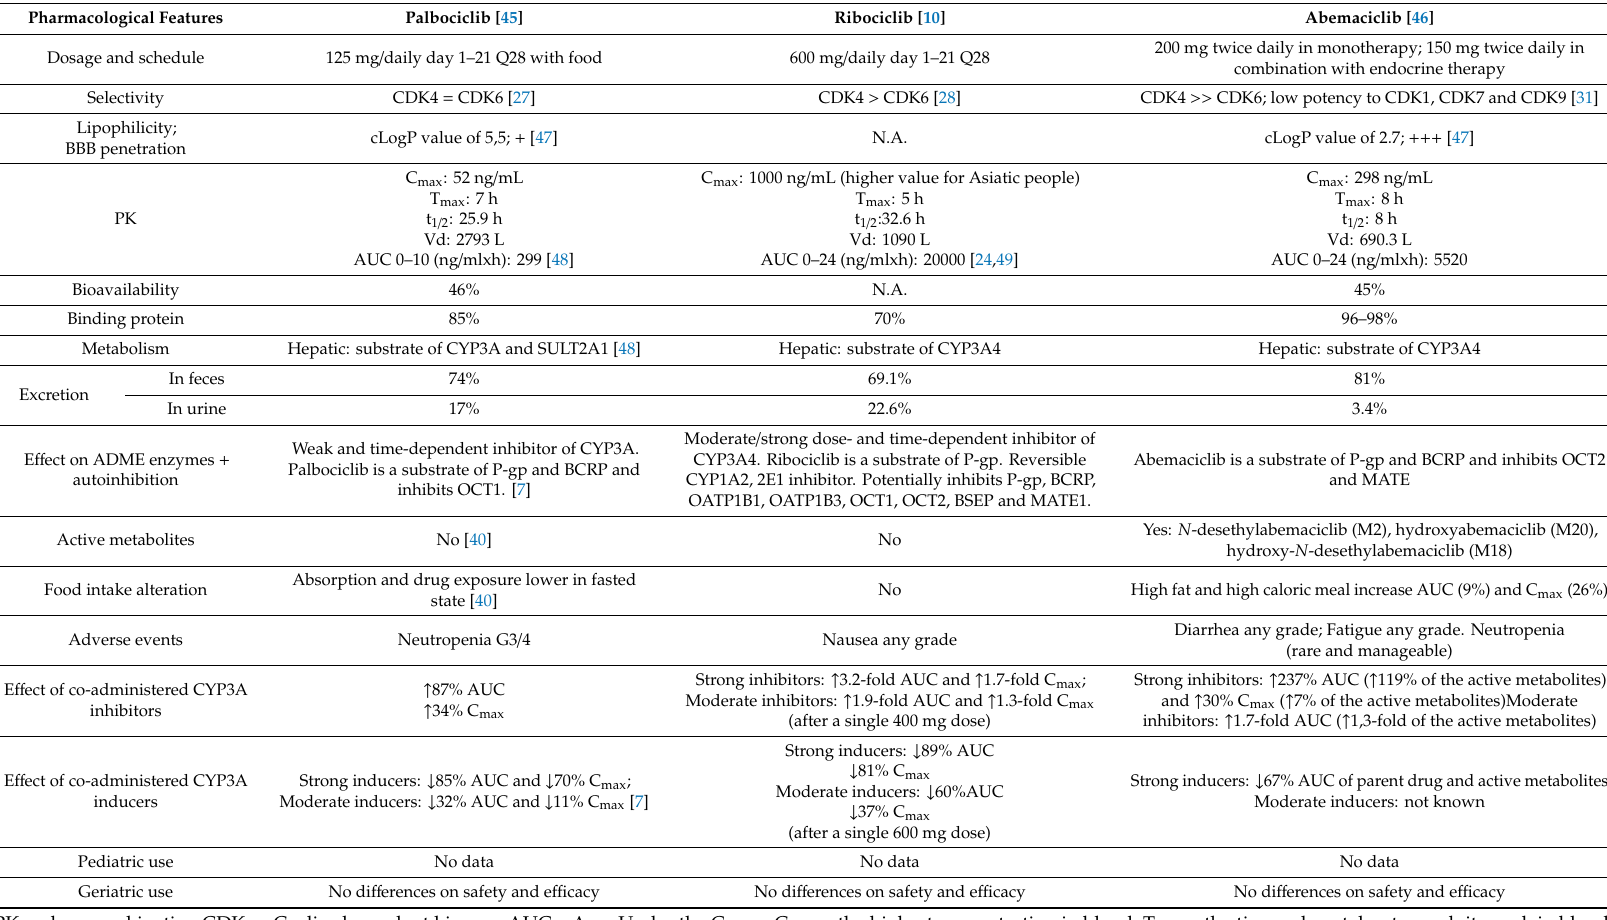
Table 3. Summary of pharmacological properties of palbociclib, ribociclib and abemaciclib in